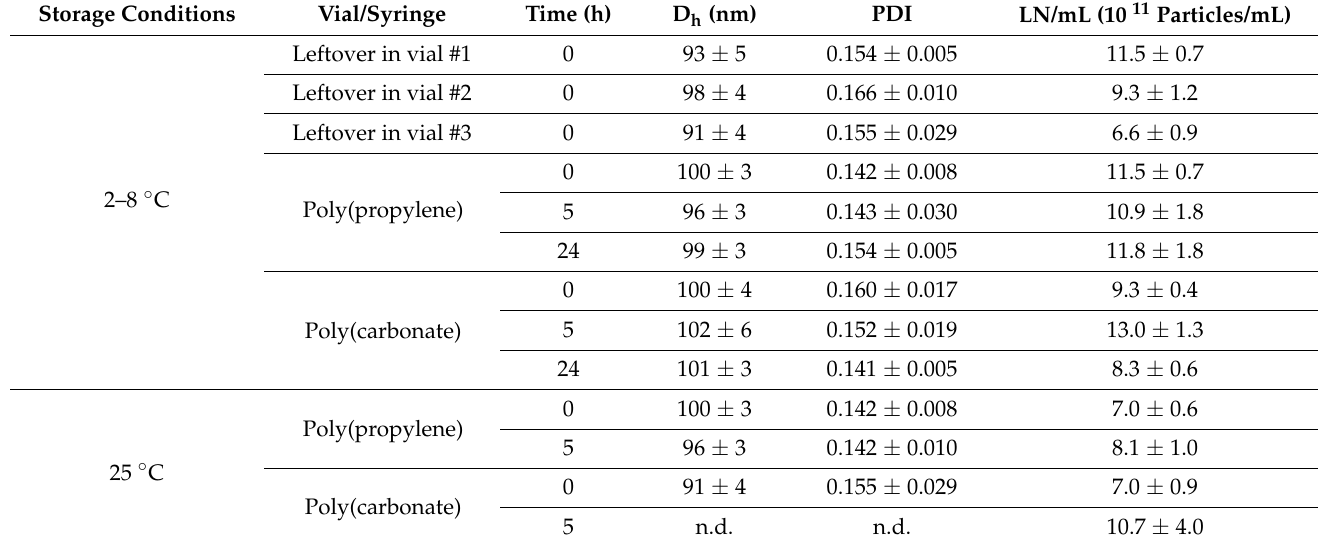
Table 1. Impact of storage and syringe material on the particle size distribution of LN expressed as the ratio of hydrodynamic diameter (D h ), which was calculated on the main peak of DLS data expressed in intensity, and polydispersity index (PDI) at different sampling